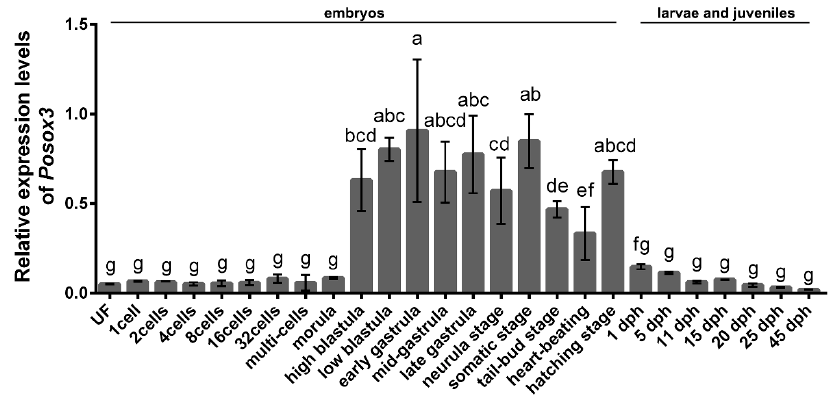
Figure 4. qRT-PCR analysis of Posox 3 during embryonic development and in larvae and juveniles. Relative mRNA level is shown as mean ± SEM ( n = 3). The relative expression variance is given as ratio (the amounts of Posox 3 mRNA/reference genes). Different letters indicate significant difference ( p < 0.05). UN, unfertilized egg; dph, days post-hatching.